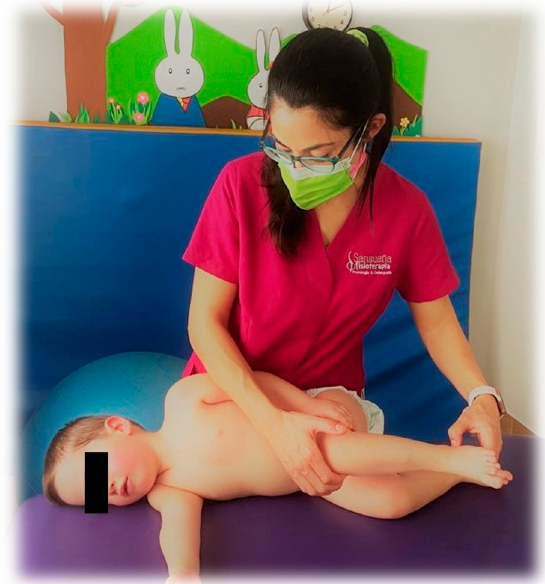
Figure 1. Second Reflex Flip Phase.